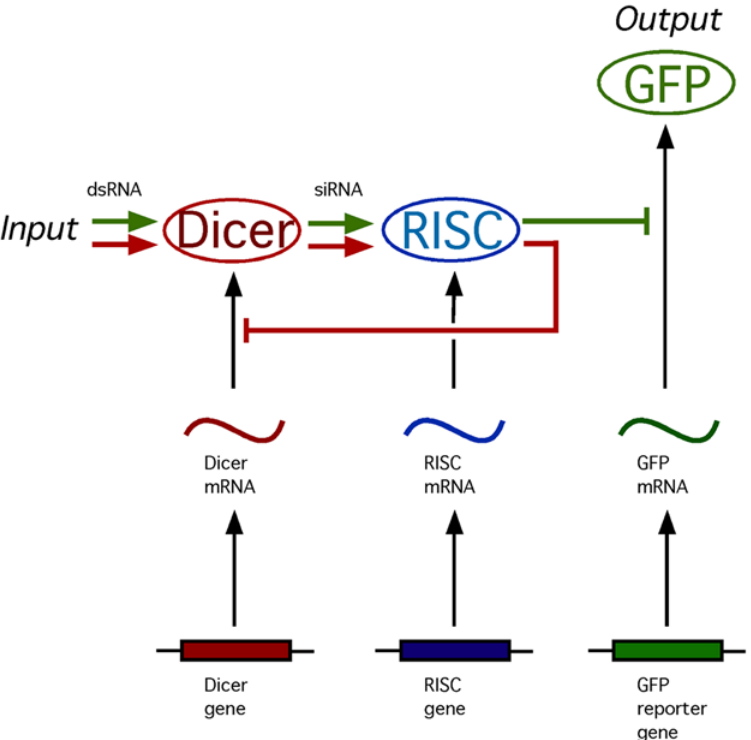
Figure 1. Diagram of recursive RNAi circuit. RNAi takes place in two steps. Following input to the system of a double stranded RNA precursor (dsRNA), Dicer chops the dsRNA into small interfering RNA molecules (siRNA) which are then used by the RISC complex to direct cleavage of target messages. At the same time, genes encoding RNAi machinery as well as the reporter construct (in this case GFP) are transcribed into mRNA and then translated into protein (indicated by ovals in the diagram). RNAi repressed gene expression by providing an extra decay pathway for the targeted message, so that rather than being translated into protein the message was destroyed. In recursive RNAi, two dsRNA molecules are provided as input, one directed against the reporter gene and the other directed against a gene encoding part of the RNAi machinery itself. The measurable output of the system is the level of reporter protein (GFP).